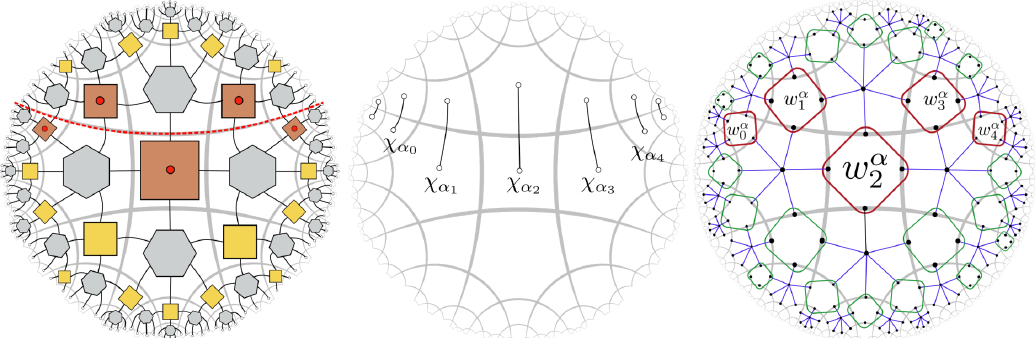
Figure 41. Going from left to right, we choose a bipartition such that the boundary degrees of freedom are divided into two complementary sets above and below the dashed line. Greedy algorithm “distills” the state χ , whose von Neumann entropies are then assigned as α -dependent α edge weights in the